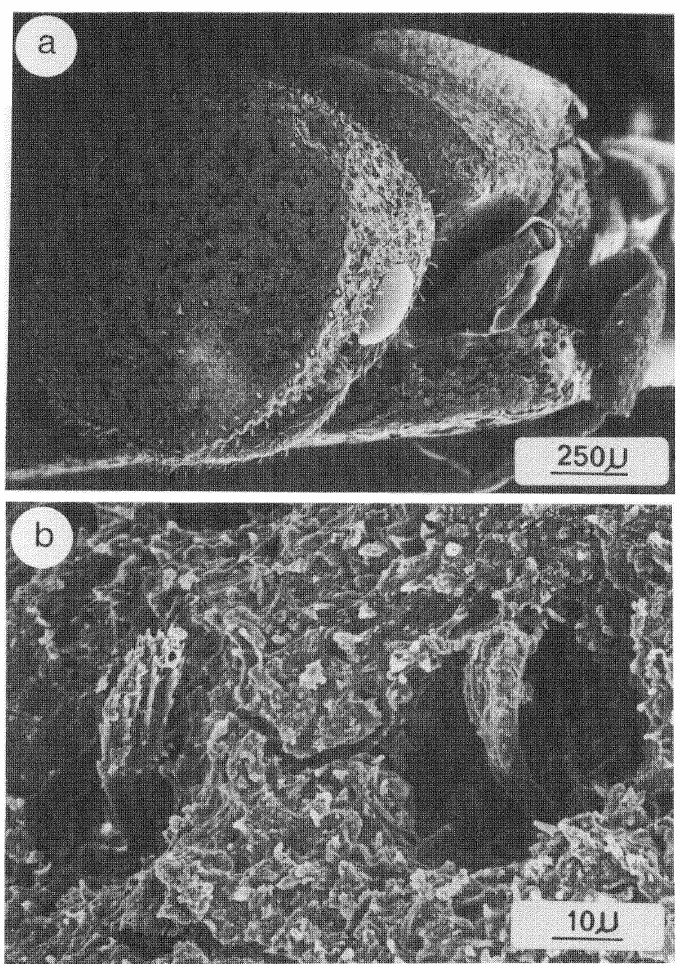
Fig. 10. Z. setulifer (Ancon, Panama). Queen. a. Head is heavily encrusted with material, b. Setae on head, with encrusting